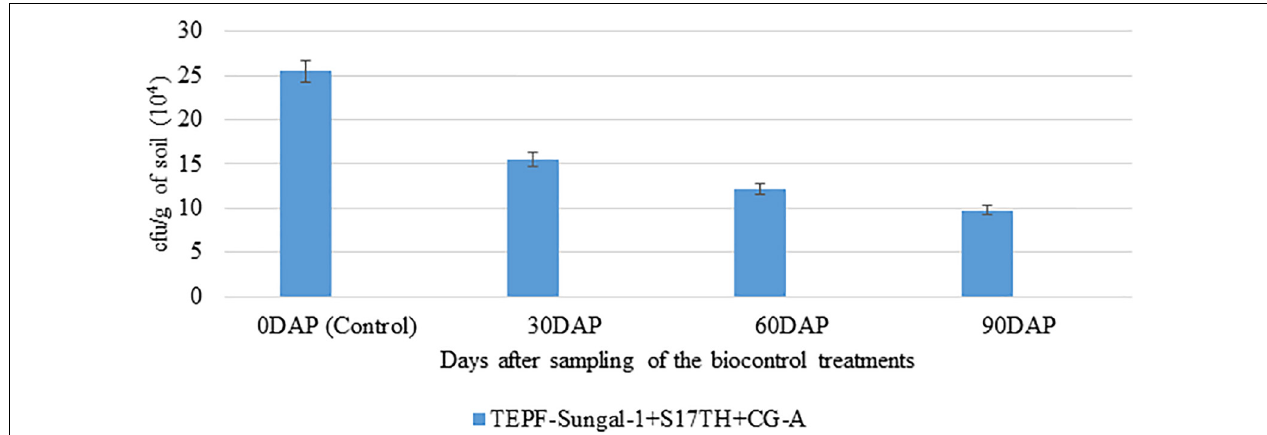
FIGURE 8 | Enumeration of Fusarium population in the rhizosphere soils of tomato treated with TEPF-Sungal-1 ( Pseudomonas putida ), S17TH (Trichoderma harzianum) and CG-A (Chaetomium globosum) under field conditions [VRF, I ARI]; *mean of three replications; the fungal colonies appeared after 3 days of plating on Fusarium selective media, Fo-Gl. Error bars indicate Standard Deviation